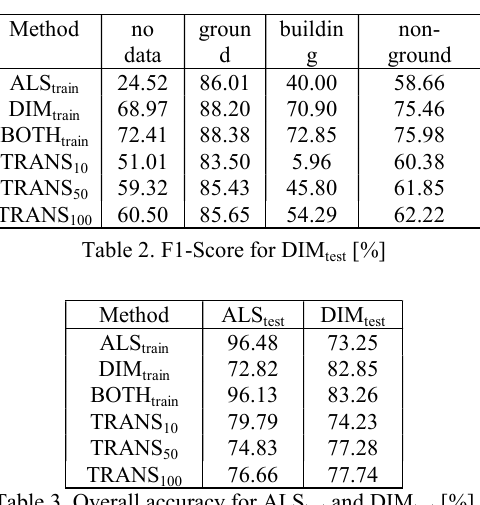
Table 3. Overall accuracy for ALS test and DIM test